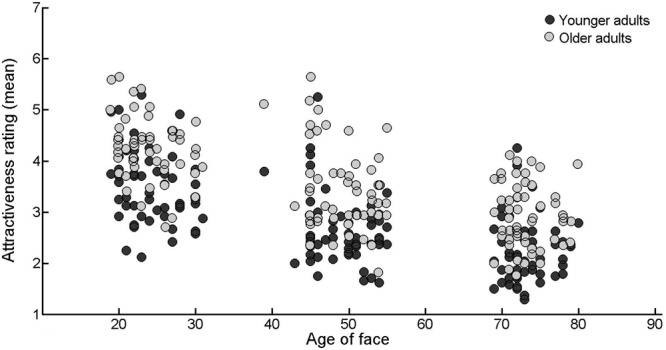
Scatterplot showing the correlation between mean attractiveness ratings and (actual) age of face.